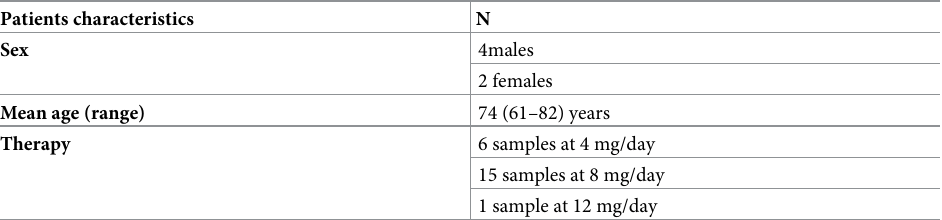
Table 6. Principal demographic and clinical patients’